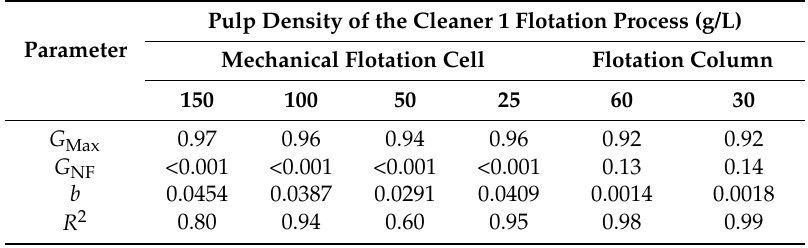
Table 6. Summary of the parameters from Equation (1) as fitted to the data in Figure